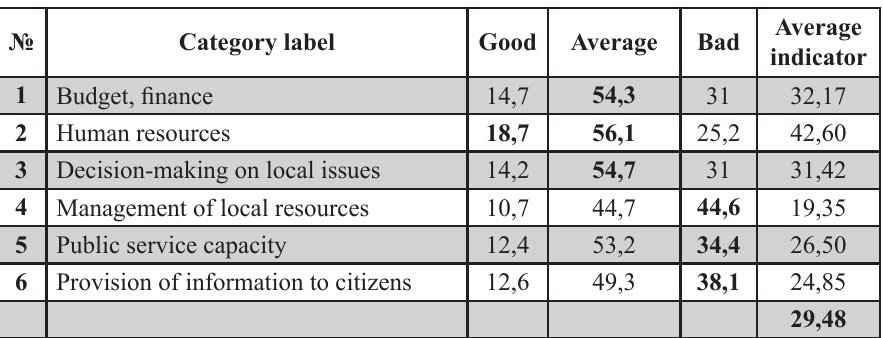
Table 11. The public evaluation of opportunities for autonomy of local governments, 2010